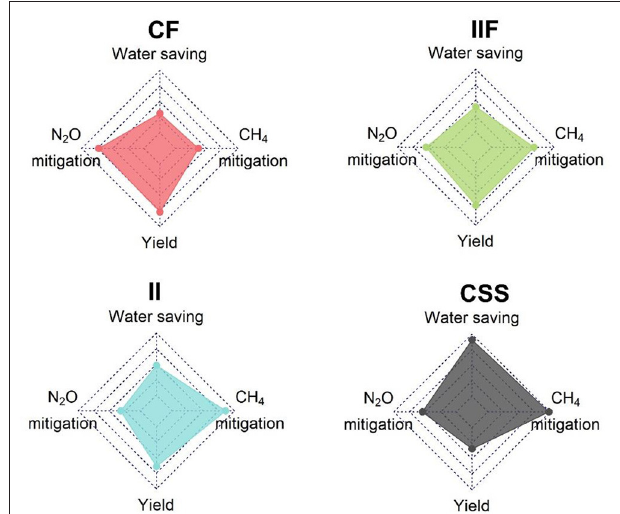
FIGURE 5 | Radar plots of 4 Climate-Smart indicators (Water Saving, yield and, N 2 O and CH 4 mitigation) under Continuous Flooding (CF), Intermittent Irrigation (II), intermittent irrigation until Flowering (IIF) and Continuous Soil Saturation (CSS). The points of the radar plots were calculated using a 0–1 normalization method based on the highest and lowest mean value of each indicator among irrigation treatments and seasons.